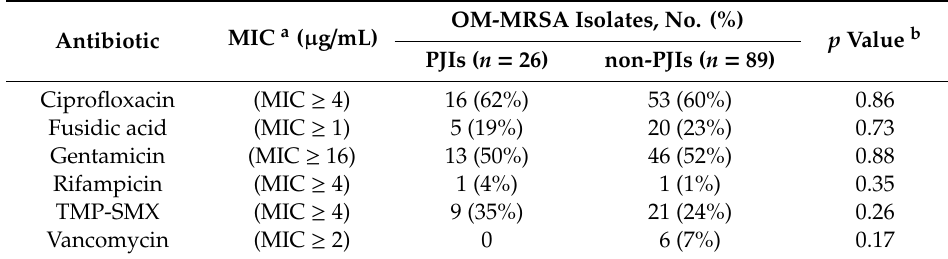
Table 10. Antibiotic resistance profiles of OM-MRSA isolates from PJIs and non-PJIs.